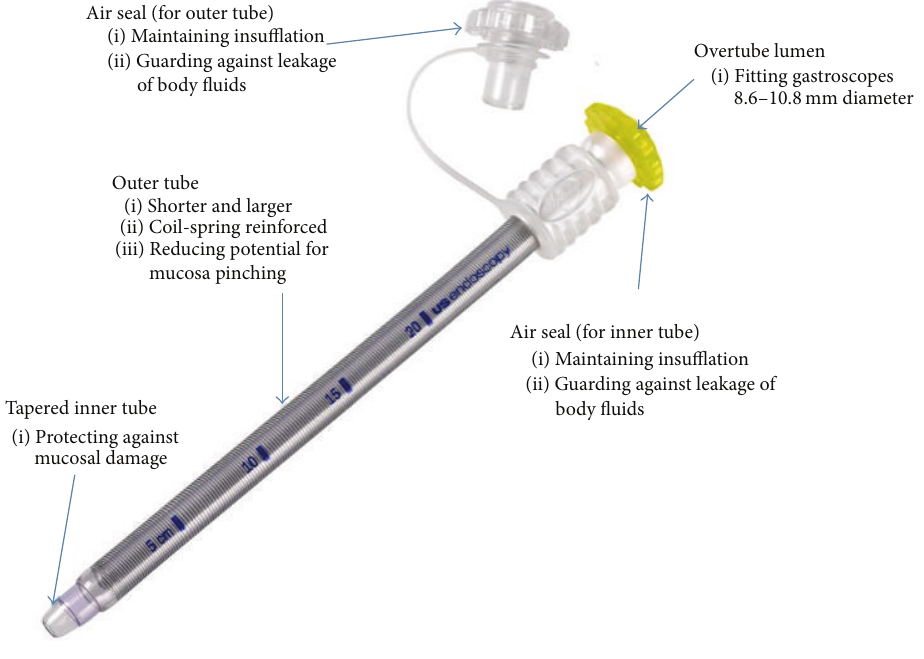
Figure 1: Guardus esophageal overtube (courtesy of US Endoscopy, Mentor,